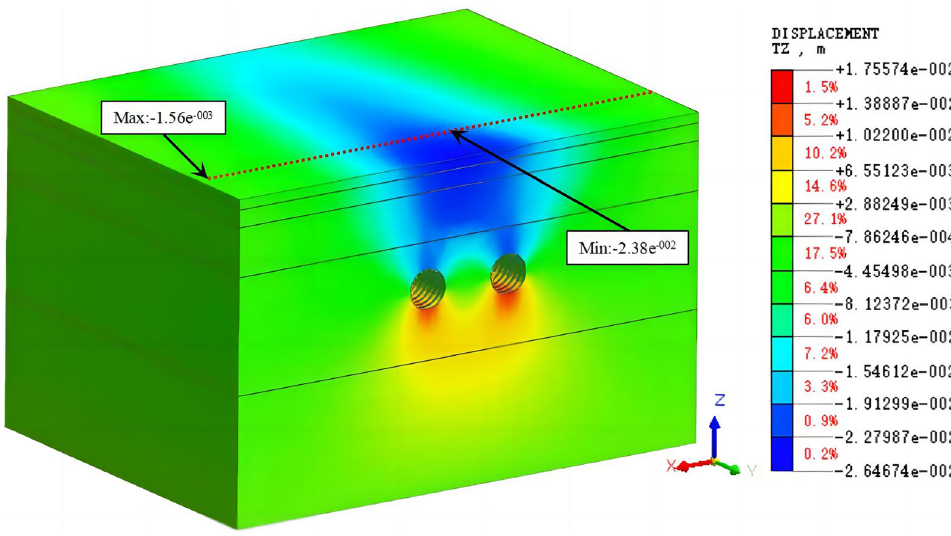
Figure 14. The cloud diagram of the vertical displacement for working condition 3 (asynchronous excavation).